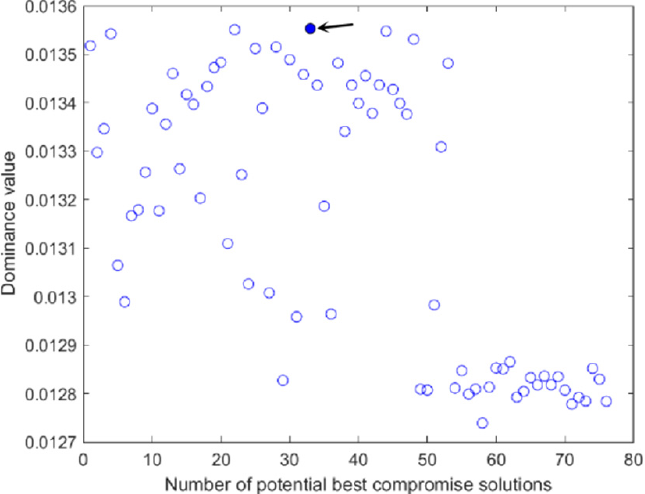
Figure 15. The dominant value of global potential optimal compromise solution. All orange points in Figure 14 are the dominant values of all Pareto front solutions in the dashed box in Figure 12. The maximum dominance value of the orange solid point pointed by the arrow is the best compromise solution of ZDM. All blue points in Figure 15 are the dominance values of all Pareto front solutions in the dashed box in Figure 13. The maximum dominance value of the blue solid point indicated by the arrow is the global optimal compromise